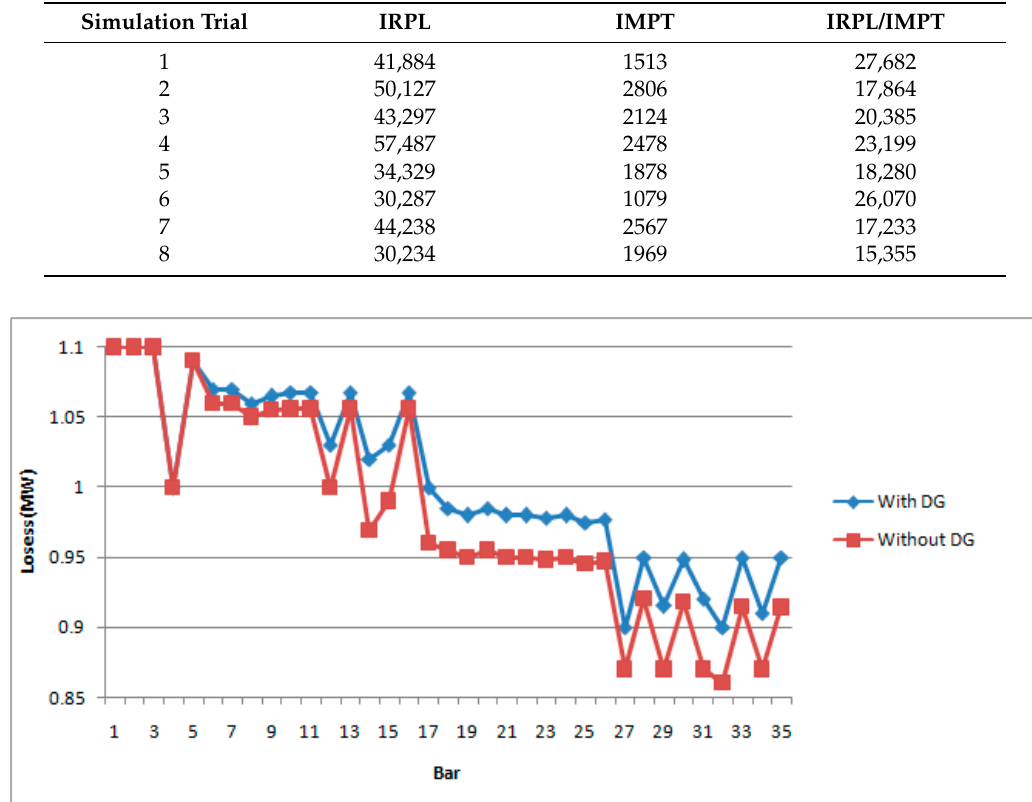
Table 3. Values of IRPL and IMPT for candidates with randomly generated solutions.